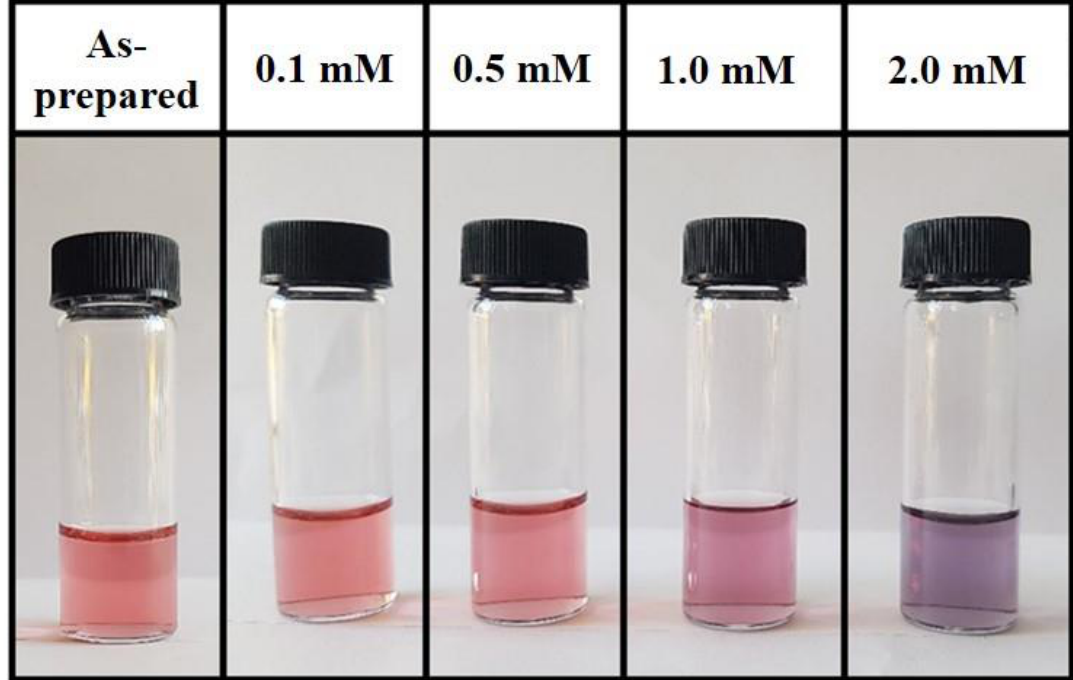
Figure 4. Picture of colloidal solutions with increasing glyphosate content from left to right.